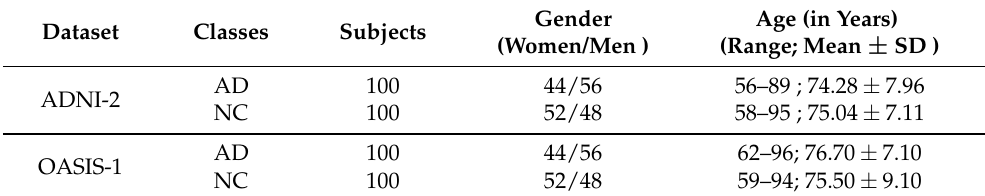
Table 1. Details of the datasets.